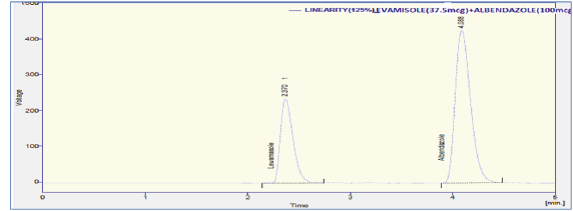
Figure 5: Chromatogram of levamisole and albendazole prepara-